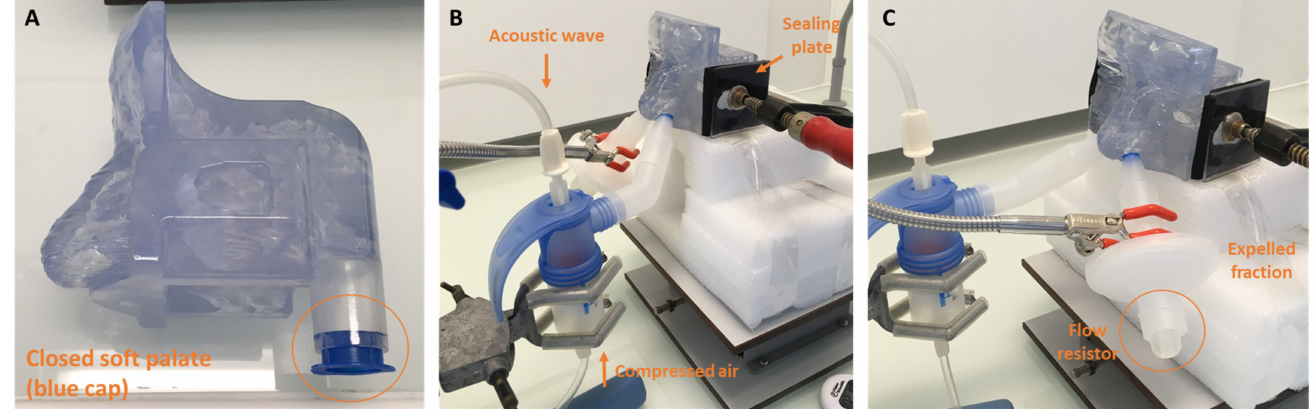
Figure 6. Experimental setup for NaF nebulization with PARI SINUS device in the closed soft palate condition. ( A ) Soft palate closed with a blue sealing cap. ( B ) The illustration shows the human nasal cast with closed soft palate and sealing of maxillary sinuses. The nebulization duration was fixed at 6 min—3 min of aerosol administration by the left nostril ( B ), then 3 min of aerosol administration by the right nostril ( C )—whereas the other nostril was occluded with a flow resistor as the procedure recommended by the manufacturer for patient use.